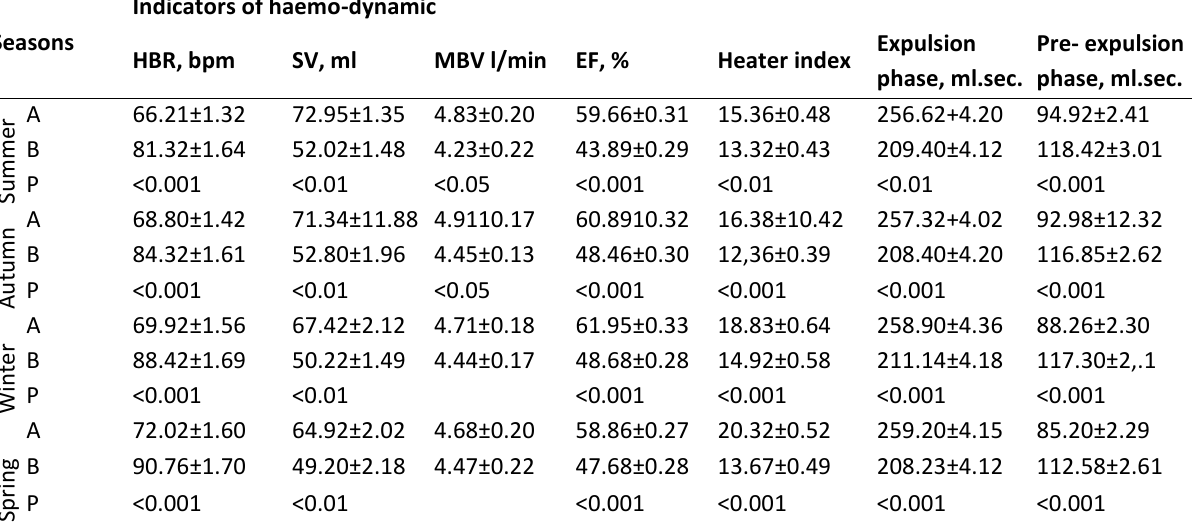
Table 5. Change of students’ blood circulation indicators under influence of orthostatic tests in different